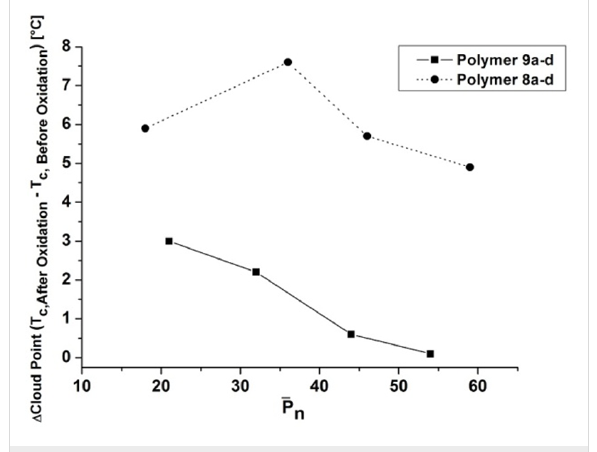
Figure 5: Shifts of the cloud points after the oxidation of the polymers ( 8a–d, 9a–d ) to its corresponding sulfoxides ( 8aOx–8dOx , 9aOx–9dOx ) as a function of degree of